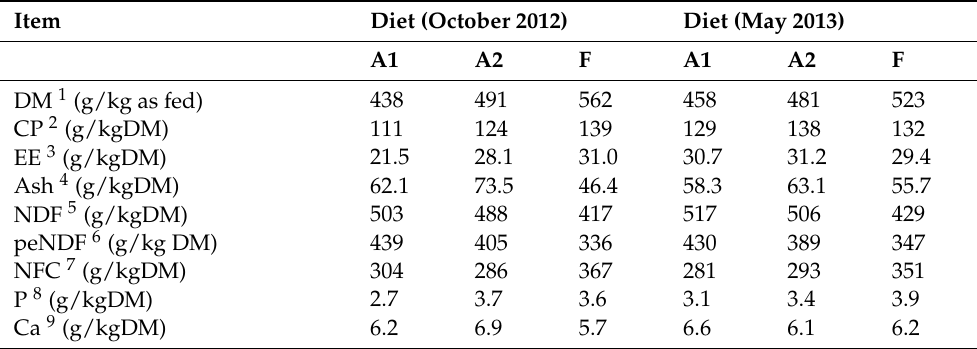
Table 2. Chemical composition of the diets used in the traditional feedlot system (i.e., A 1 = Adaptation diet 1; A 2 = Adaptation diet 2; F = Finishing diet).